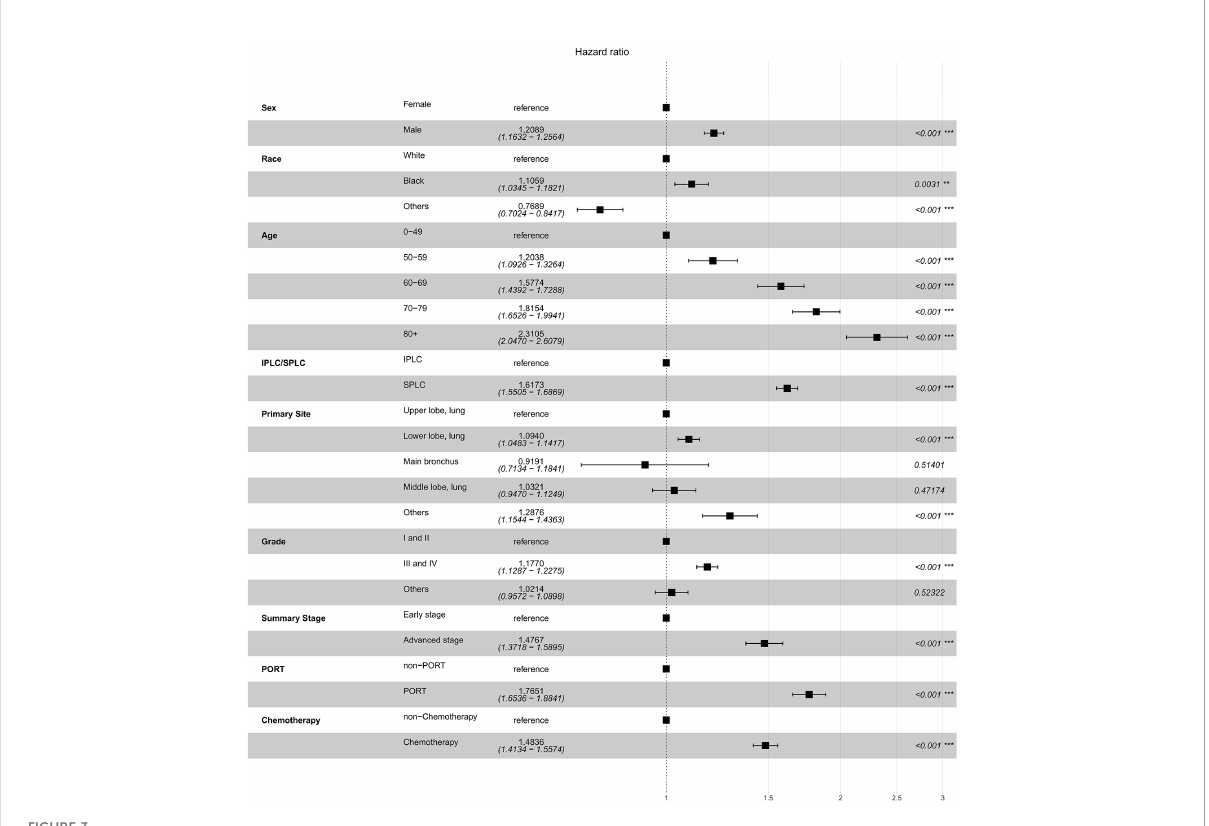
FIGURE 3 Adjusted survival curves for survival possibility among patients with SPLC vs.